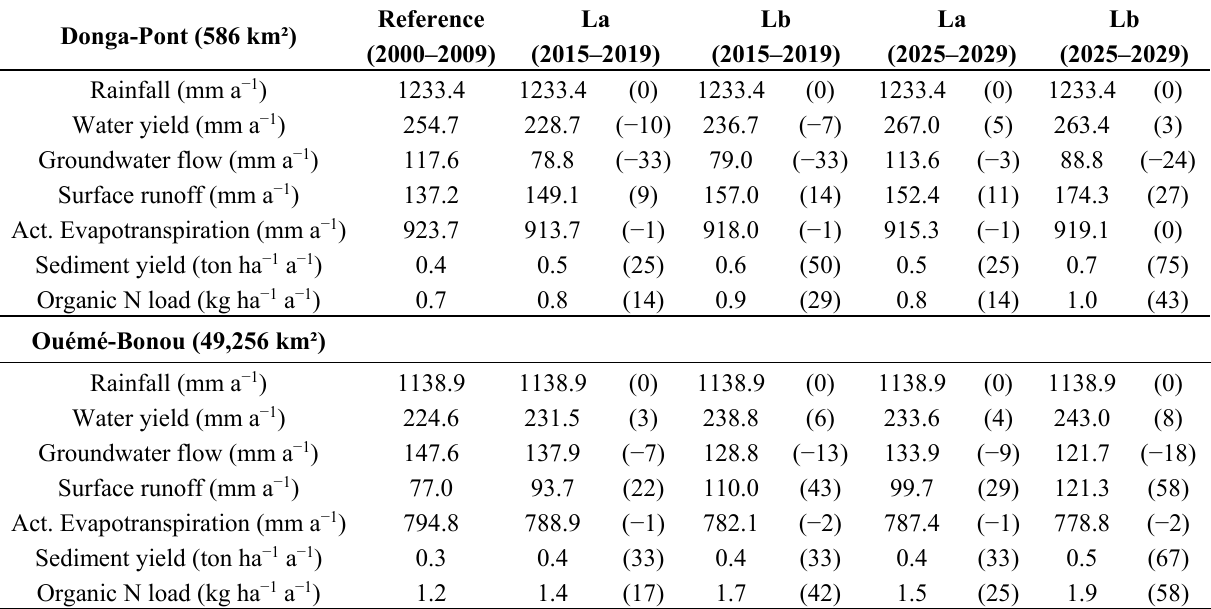
Table 10. Simulated SWAT components under land use scenarios (with unchanged climate condition of the period 2000 to 2009). Deviation (in %) from the reference scenario (2000–2009) are shown in brackets.